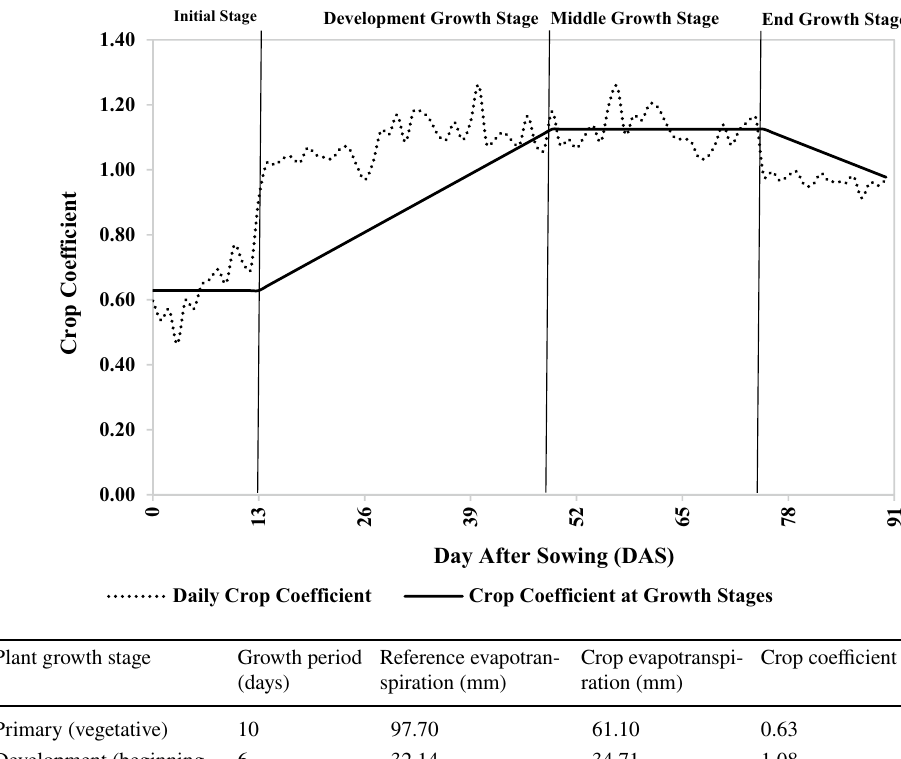
Table 5 Basil growth stages and plant coefficient values in full irrigation treatment